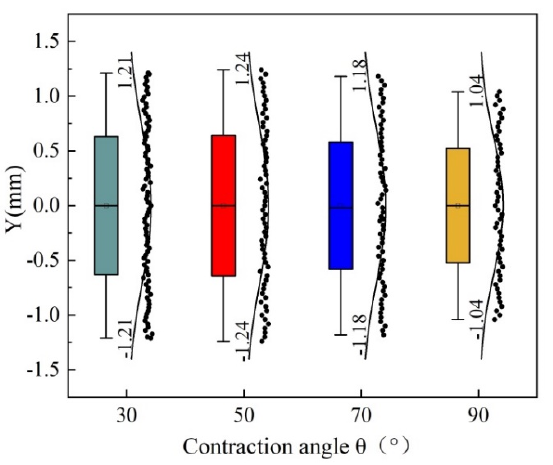
Figure 5. Effect of contraction angle on the effective Y-axis extension distance of water jet at X = 100